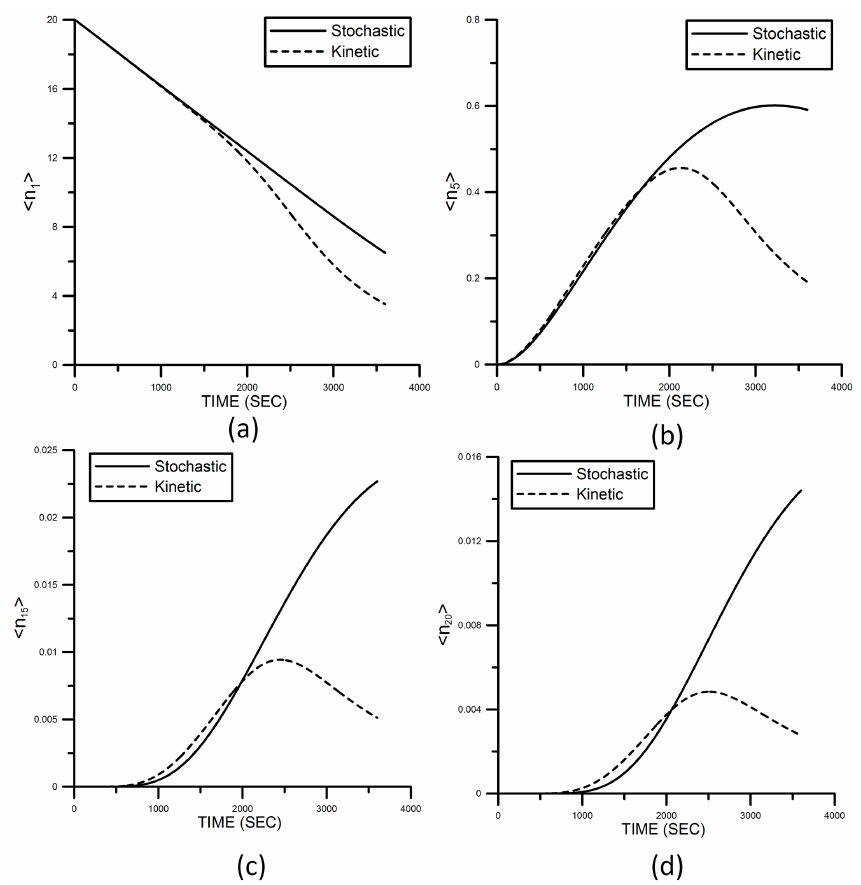
Figure 10. For the turbulent hydrodynamic kernel, comparison of the expected values (cid:104) n k (cid:105) obtained from the stochastic master equation (solid line) with that of the KCE (dashed line), for a 1cm 3 system containing initially 20 droplets of 14µm and 10 droplets of 17µm. The time evolution of the expected values are shown for k = 1, 5, 15 and 20 (panels a , b , c and d , respectively). For the small masses k = 1